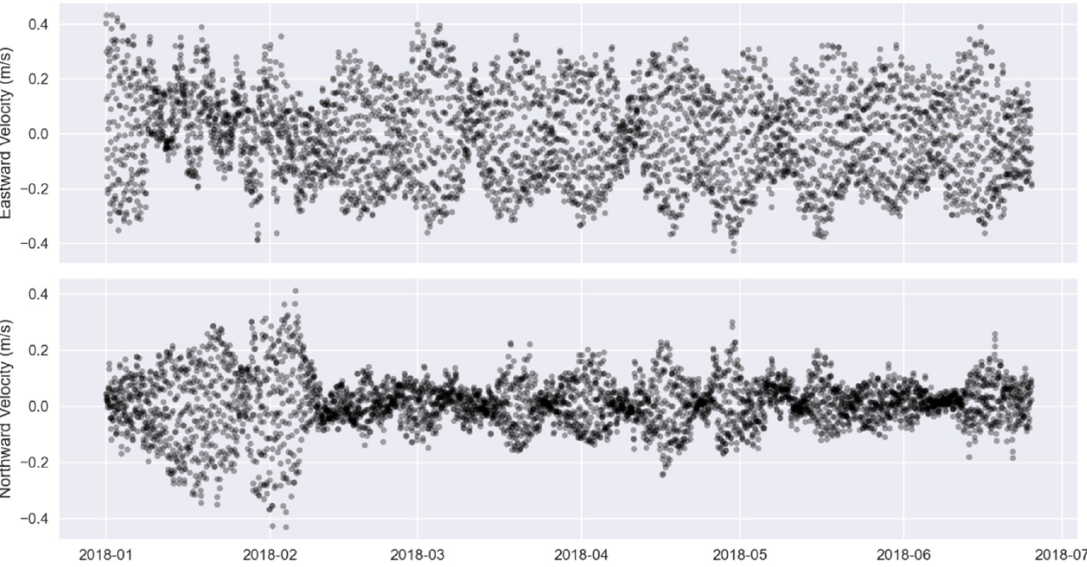
Figure 4. Time series of the hourly observed eastward and northward near-bottom currents at a site (130°23 ′ W, 53°6.5 ′ N, open circle, Figure 1) in the northern reef.